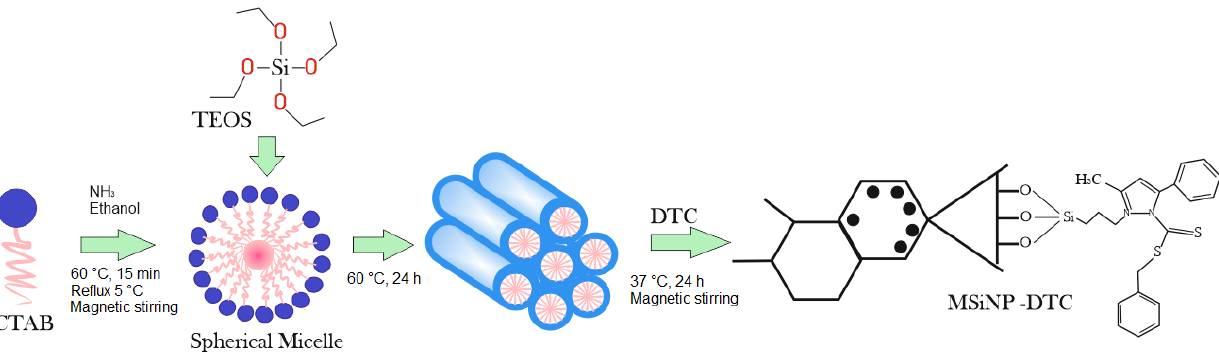
Figure 2. Schematic representation of the synthesis process of MSiNPs and MSiNP-DTC (Adobe Photoshop CC2014) .